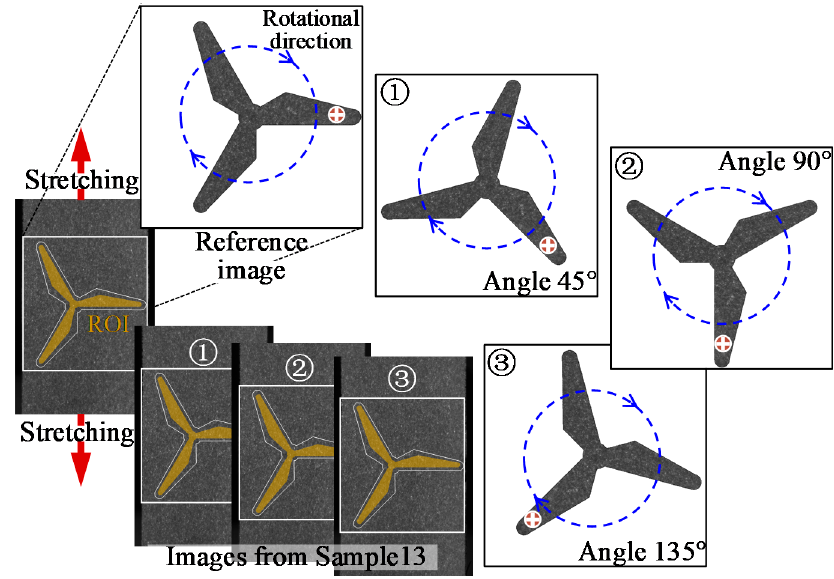
Figure 5. Schematic diagram of simulated rotating blade.